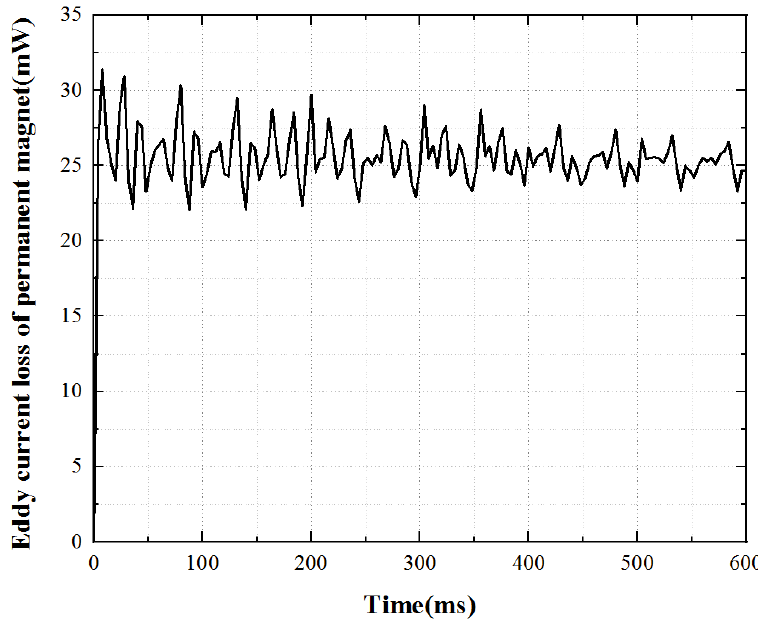
Figure 7. Eddy current loss curve of the permanent magnet.